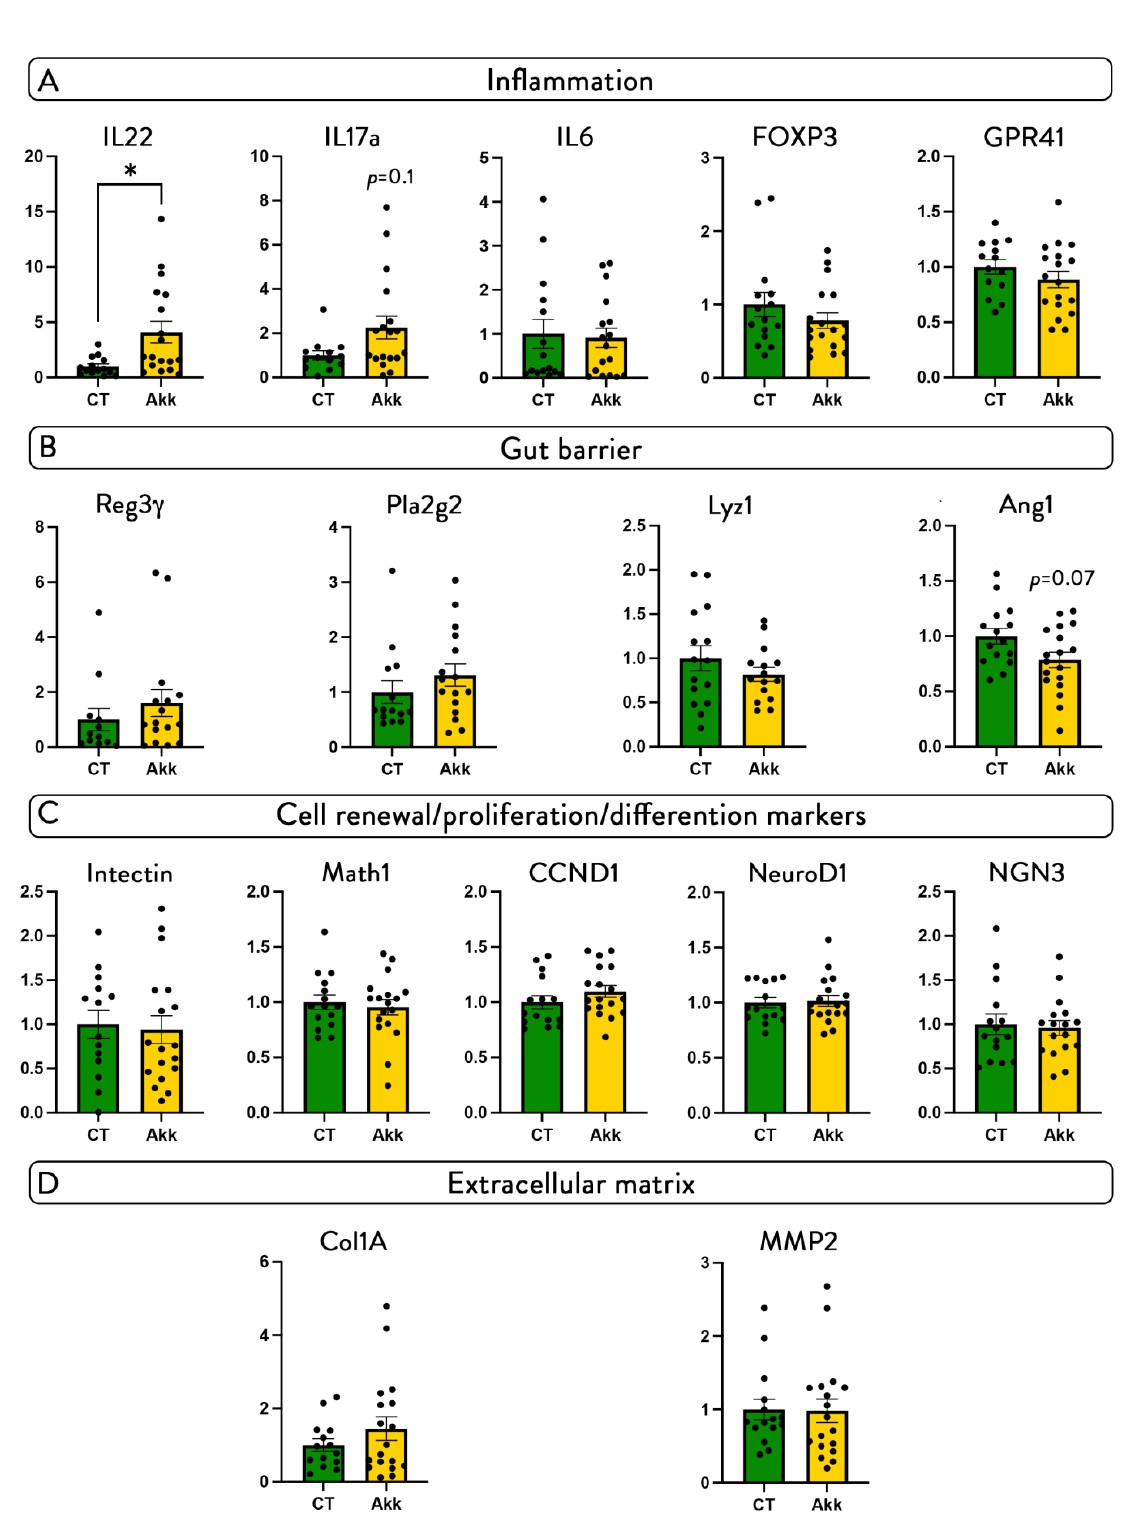
Figure 4. A. muciniphila administration increases IL22 and IL17 without affecting other markers of inflammation, gut barrier, cell renewal, proliferation markers, and matrix formation. Relative mRNA expression of markers of ( A ) inflammation, ( B ) gut barrier integrity, ( C ) cell renewal, pro- liferation, and differentiation, ( D ) extracellular matrix at the site of perforation. Data are shown as mean ± SEM, black dots (dotplots) represent individual values for each animal; * p -values were obtained after non-parametric Mann–Whitney